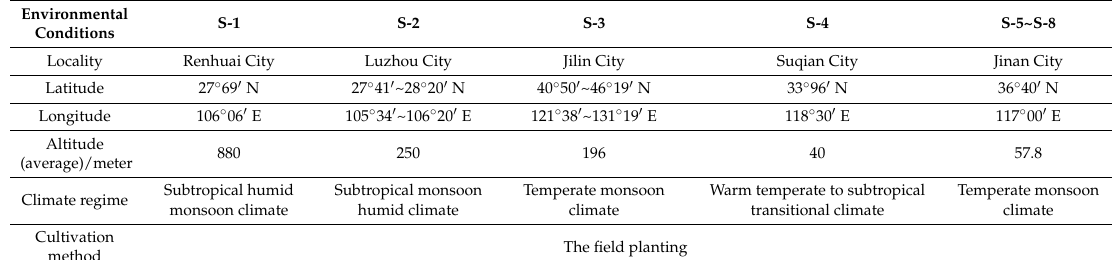
Table 1. The geographic information of the analyzed sorghum